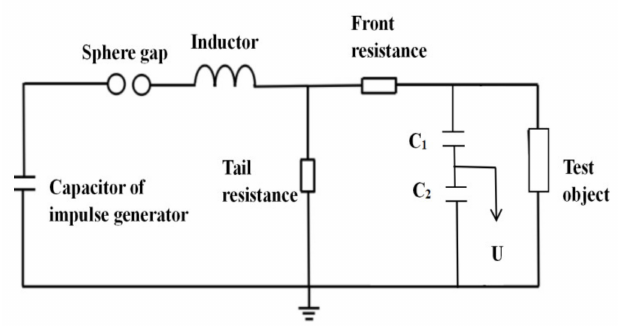
Figure 8. Equivalent circuit diagram of lightning impulse discharge test circuit.